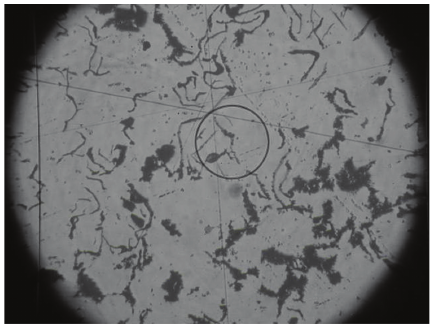
Figure 5: Microstructure in zone F 100x.